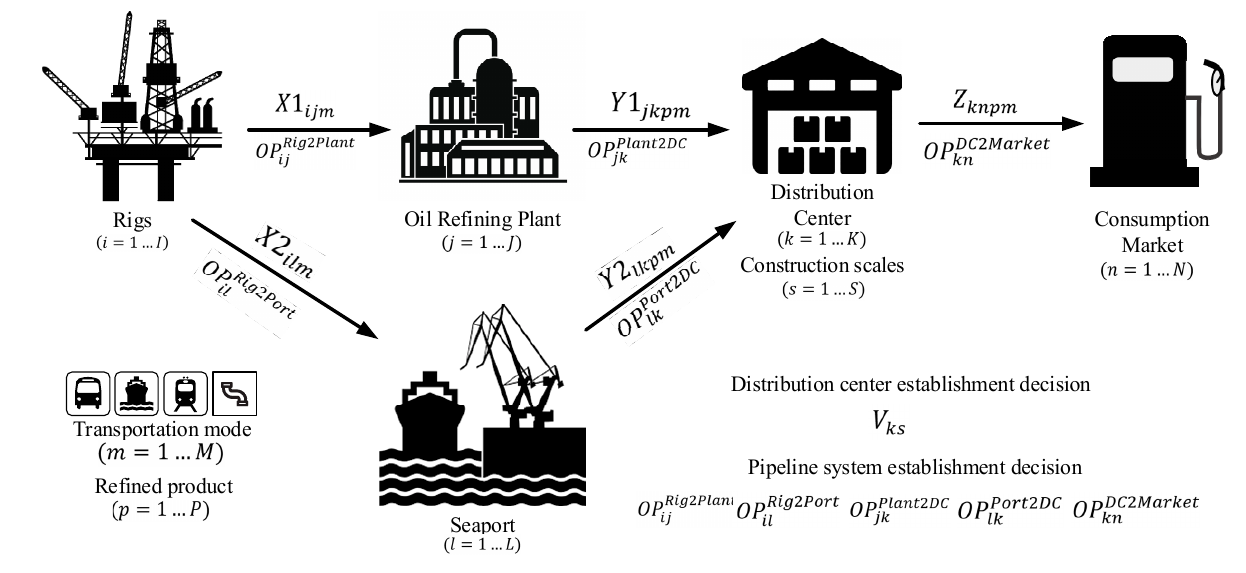
Figure 4. Fuzzy parameter membership function.